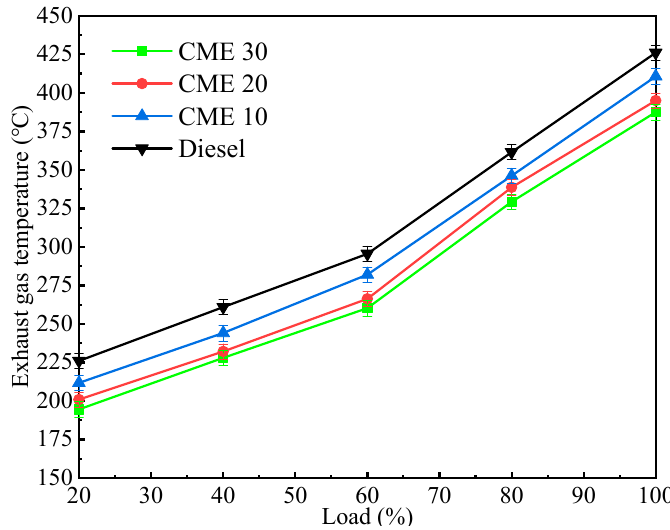
Figure 19. EGT comparison of CME biodiesel blends and diesel under different loads [210]. Raman et al. [175] investigated the performance and emission characteristics of bio ‐ diesel using biodiesel produced from rapeseed oil by transesterification in a single ‐ cylin ‐ der, four ‐ stroke, compression ignition, and direct injection diesel engine. EGT increased with increasing brake power, and higher concentrations of biodiesel increased EGT. The main reason for this phenomenon is that the oxygen content in biodiesel enhances the combustion process, resulting in higher EGT. Baweja et al. [203] conducted experiments using a single ‐ cylinder, four ‐ stroke, water ‐ cooled diesel engine to investigate perfor ‐ mance and emission characteristics using mustard oil biodiesel. According to their re ‐ search, the EGT of the blends mainly depends on the fuel and engine operating specifica ‐ tions. The B10 blend had the lowest EGT from 25% to 100% loading. This may be due to the oxygen content of biodiesel, which promotes complete combustion despite its lower calorific value. While under full load conditions, the mixtures B20, B30, and B40 showed higher EGT values. The higher injection volume of biodiesel, higher density, bulk modu ‐ lus than diesel, and slow combustion of high ‐ viscosity mixtures are the main reasons for the higher EGT.